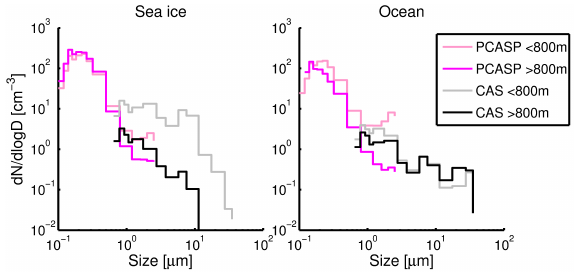
Figure 14. PCASP and CAS-DPOL particle size distributions over sea ice and ocean. Data are split into lower and higher than 800m to reflect altitude influences. Only out-of-cloud (CDP LWC ≤ 0.01gm − 3 ) data are